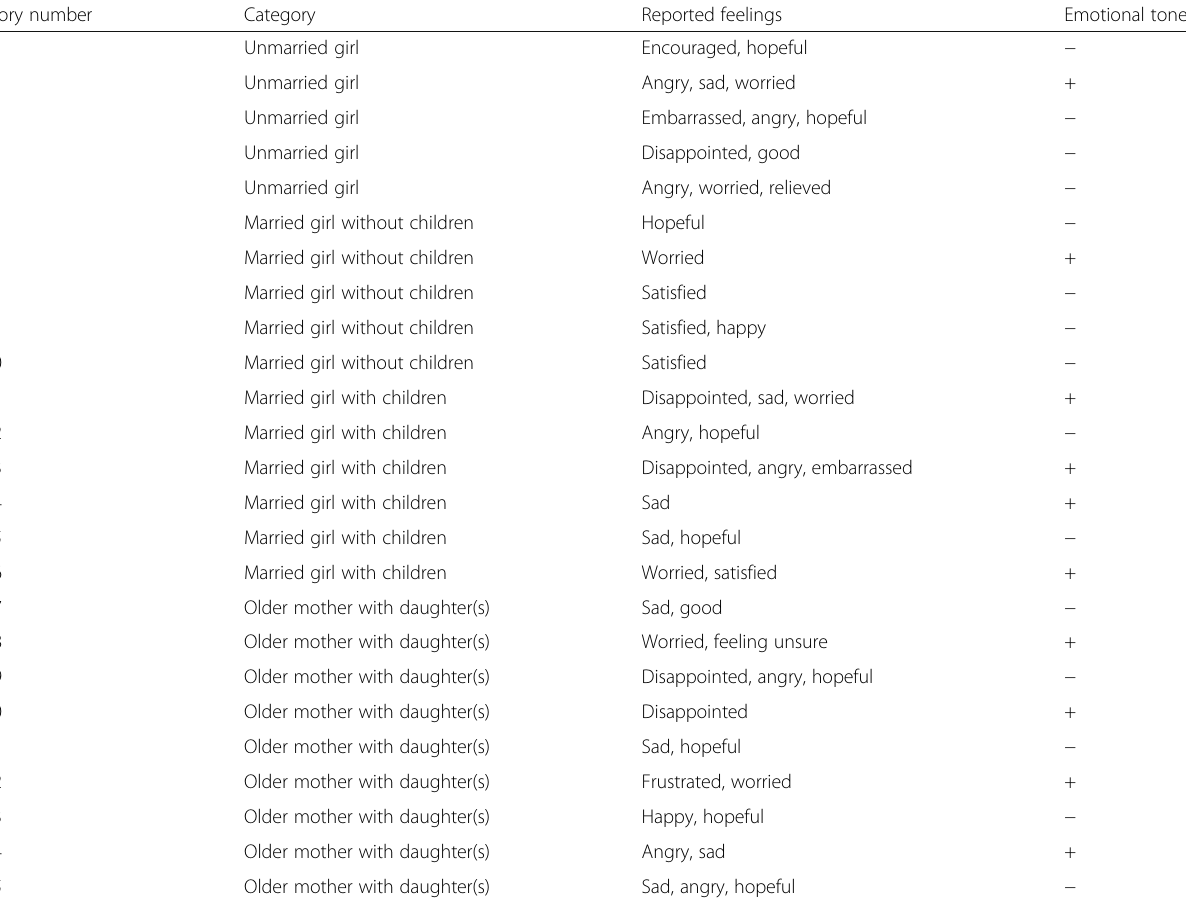
Table 1 Story number, participant category, reported feelings, and emotional tone Story